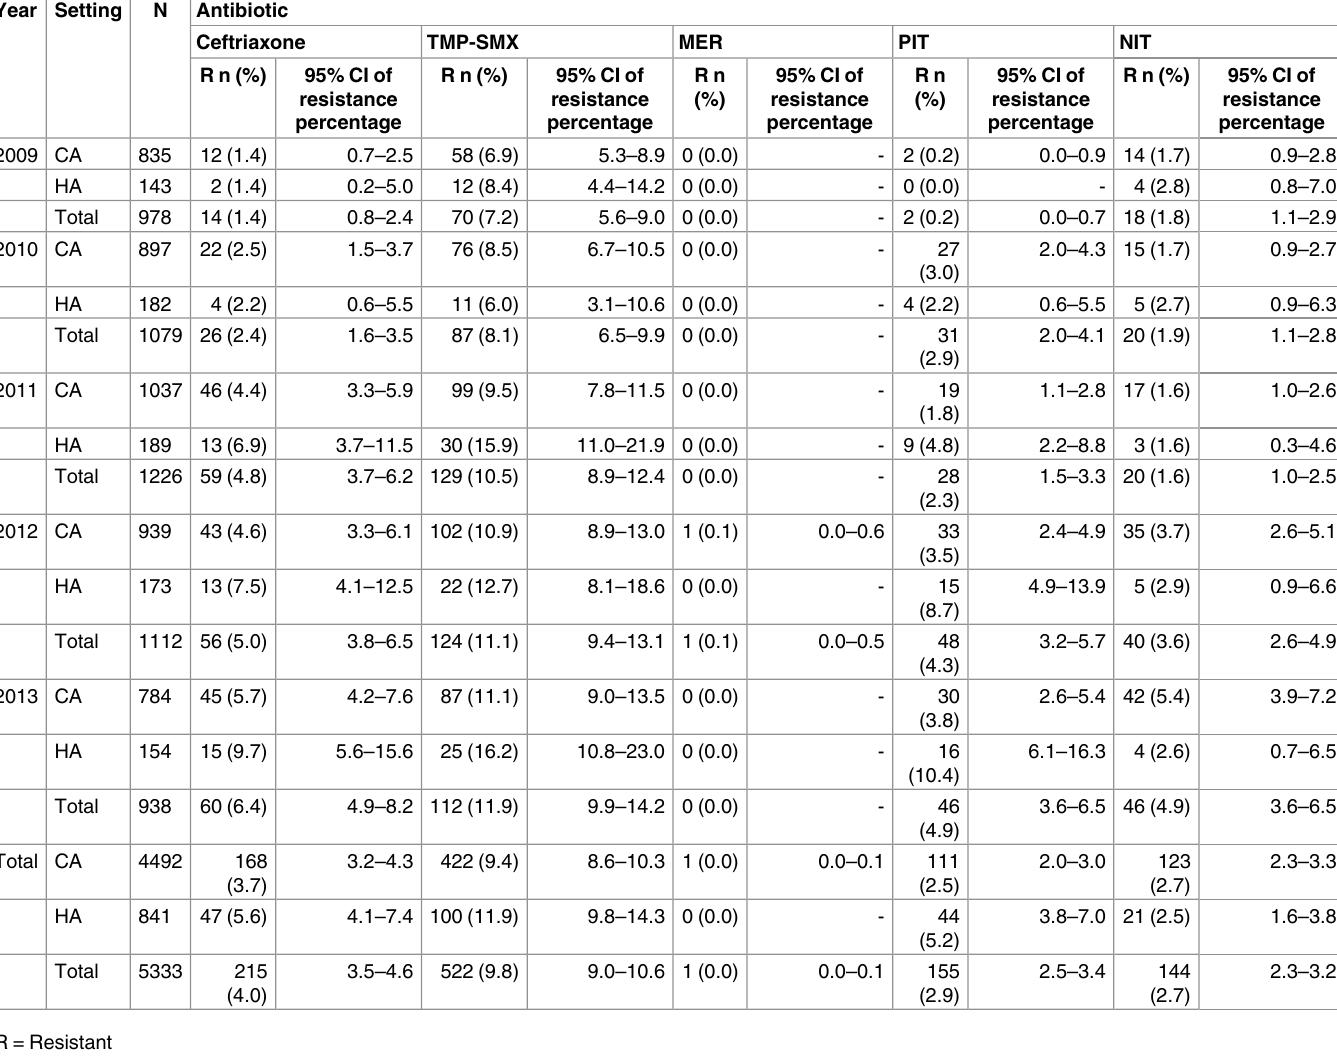
Table 2. Resistance profile of urinary E . coli isolates sent for further testing on Vitek2 from 2009 to 2013 by